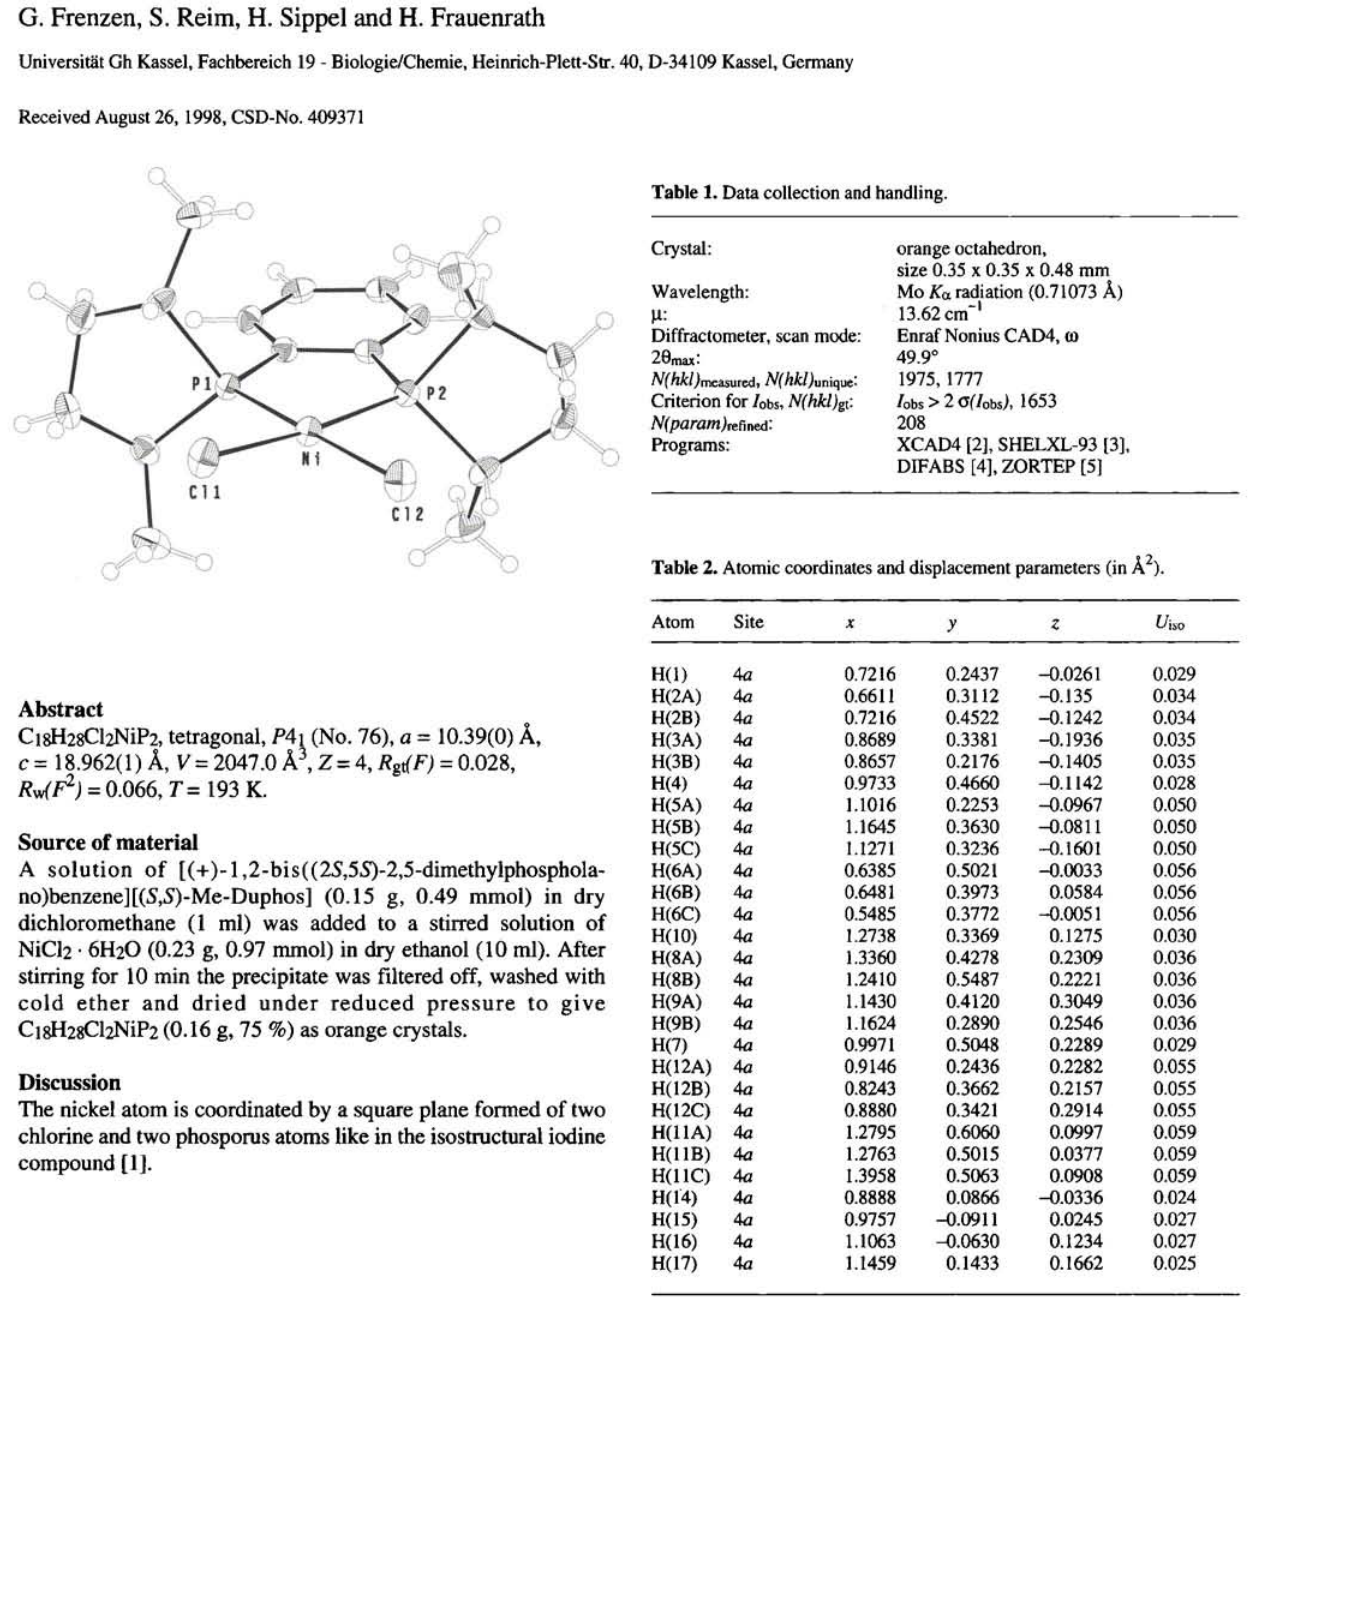
Table 1. Data collection and handling.